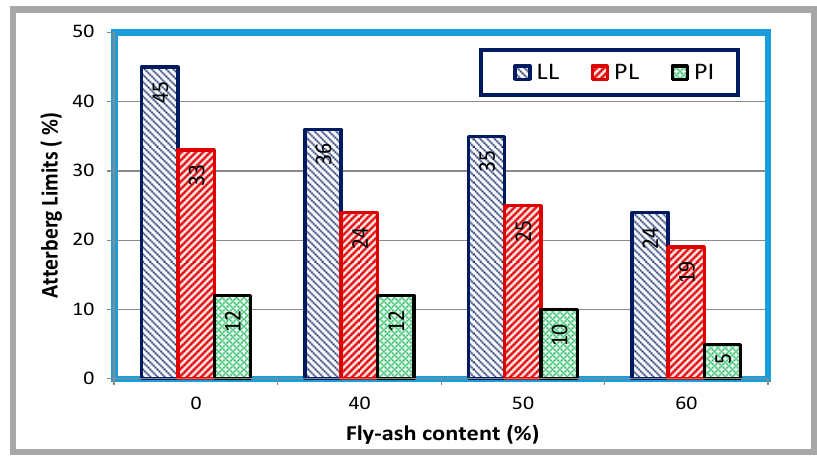
Figure 10. Variation of Atterberg limits with fly ash content .